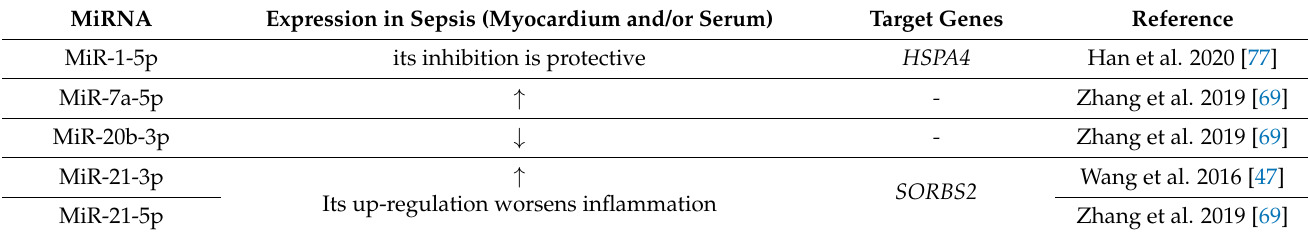
Table 2. MiRNAs involved in sepsis-induced cardiac